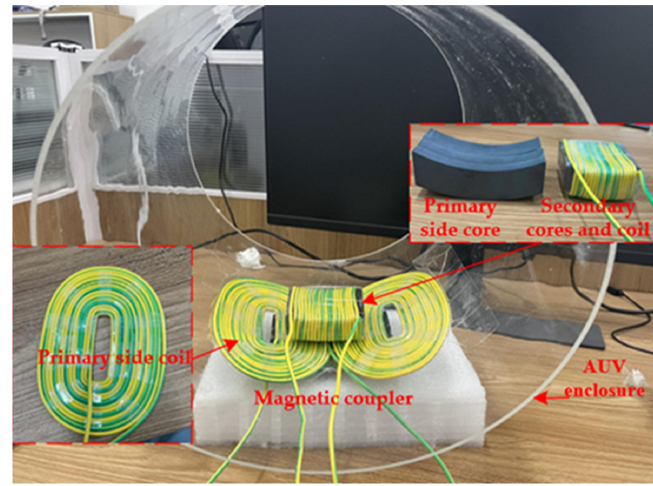
Figure 13. Diagram of the magnetic coupling unit and the overall AUV system. Table 3. Parameters of the new cores measured by the LCR measuring instrument. Parameters